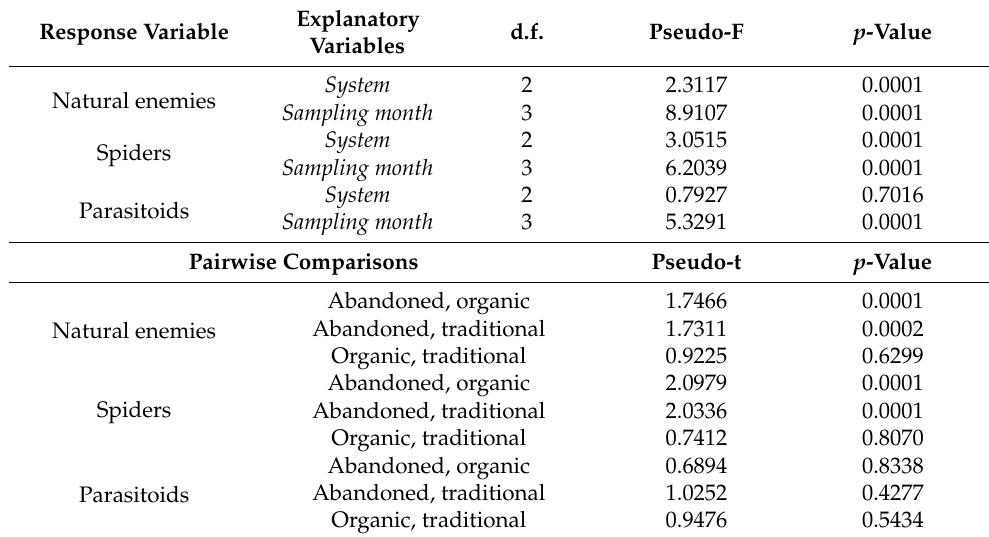
Table 1. Results of the PERMANOVA for the variables system and sampling month (full model results and pairwise comparisons among the three